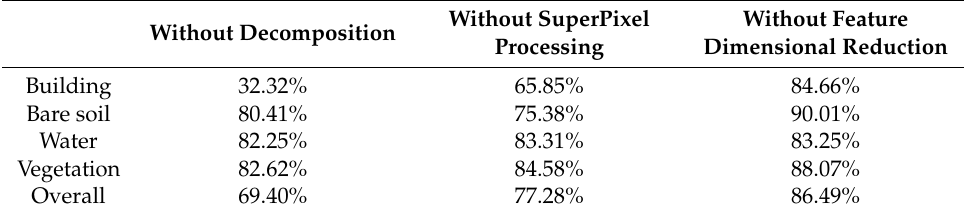
Table 4. Accuracy of the individual classification results in Figure 11. Without Decomposition